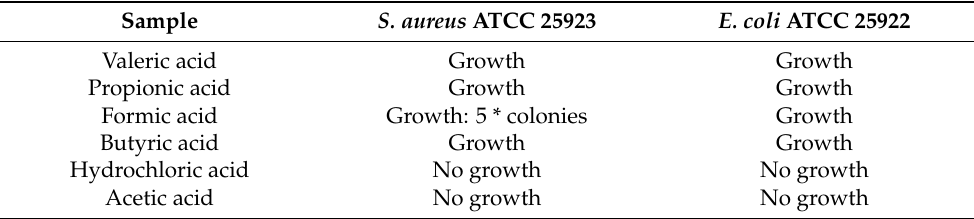
Table 6. Effects of modification of chitosan-based materials on microbial growth for nonwovens modified by vapors of various acids (obtaining modified materials under gassing conditions). Sample